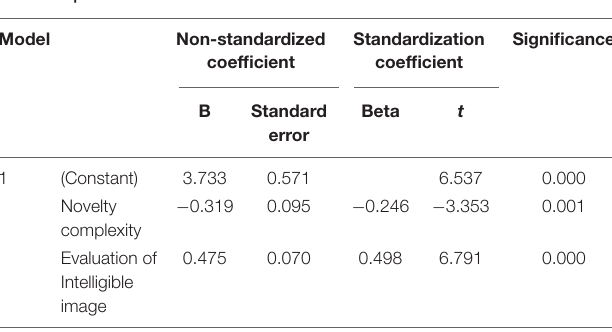
TABLE 9 | Coefficient a .